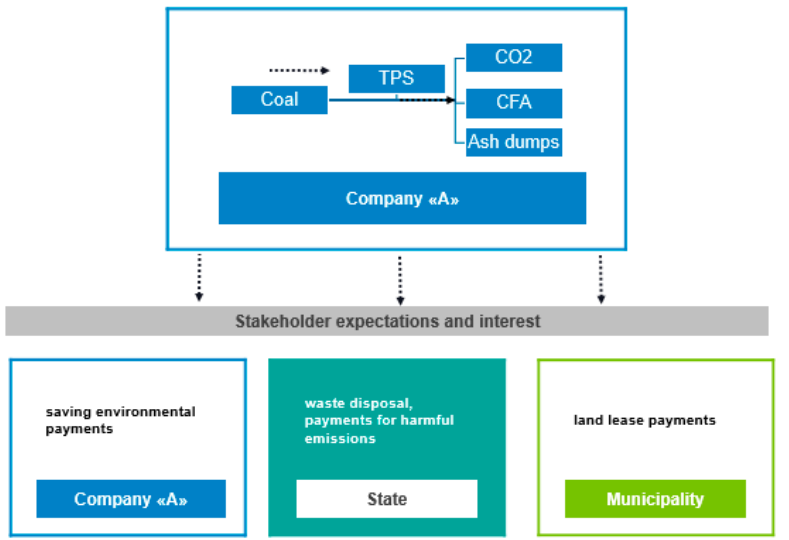
Figure 2. Diagram of the waste formation process, company payments to the state, and municipal budgets. Source: designed by authors.